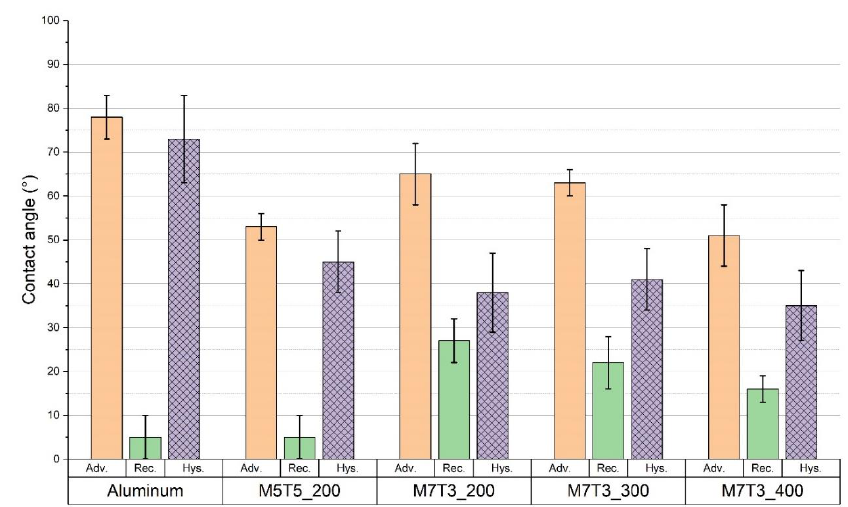
Figure 1. Contact angles of the bare aluminum and the aluminum coated with silica film with different methyl triethoxy silane (MTES)/tetraethyl orthosilicate (TEOS) ratios and different thermal annealing before condensation tests.